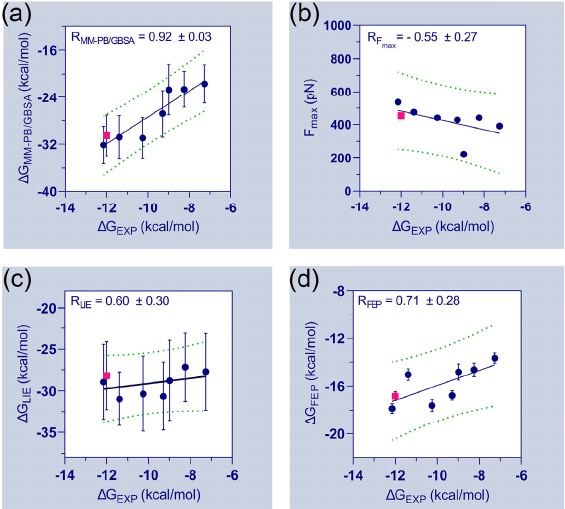
Figure 3. Relationship between experimental and estimated binding energies. In addition to the correlation coefficients of each matrix, the correlation plots of ( a ) ∆ G EXP vs. ∆ G MM − PB/GBSA ( b ) ∆ G EXP vs. F max ( c ) ∆ G EXP vs. ∆ G LIE and ( d ) ∆ G EXP vs. ∆ G FEP are determined. The experimental and computed binding energies of FLT3 D835Y –C31 are shown in pink. Standard errors of correlation coefficients are estimated using 1000 bootstrapping runs.